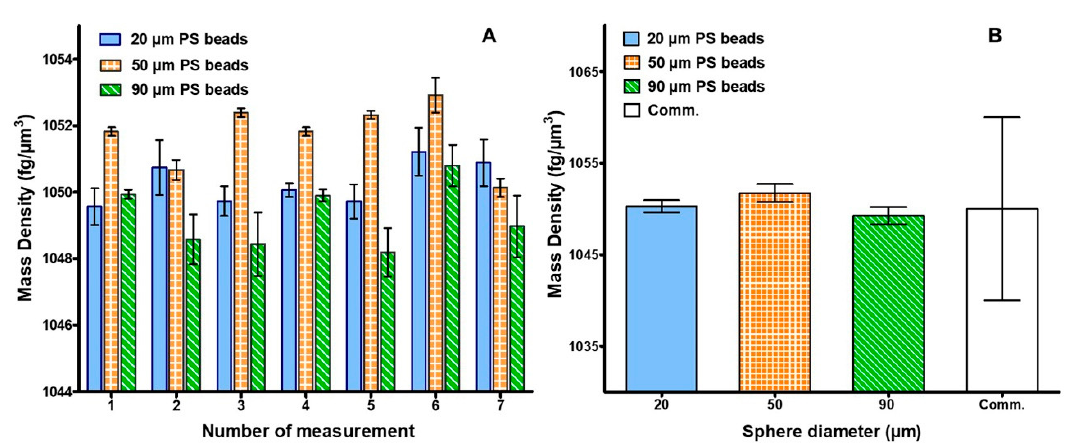
Figure 3. ( A ) Average mass density value and SD, over seven repetitions, for each of the seven measurements performed for the 20, 50 and 90 µm purchased PS beads (blue, orange and green respectively); ( B ) Overall average value and SD for each bead size compared to the PS assigned commercial value and SD.